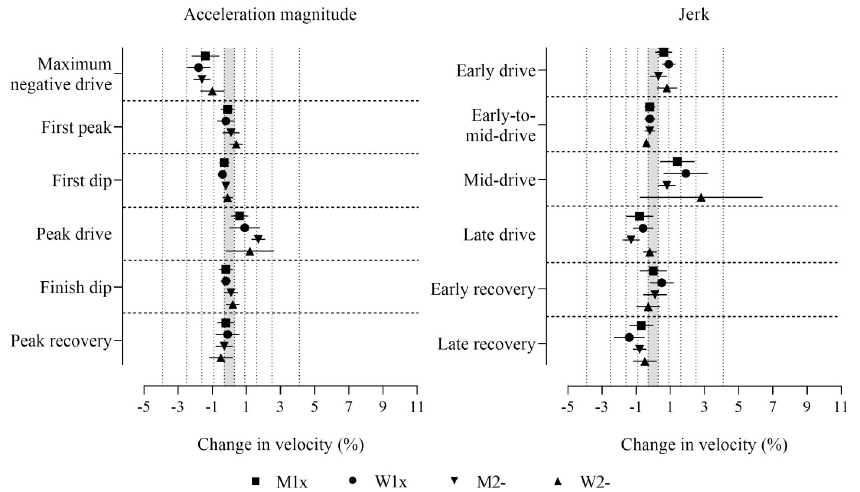
Fig 5. Change in boat velocity for a change in predictor variables of two within-crew standard deviations with adjustment for power output and stroke rate. Data are mean (%) and 90% compatibility intervals. The shaded grey area covers trivial values (values within the smallest substantial change thresholds, -0.3 to 0.3%). Vertical dotted lines delineate threshold magnitudes of small ( ± 0.3%), moderate ( ± 0.9%), large ( ± 1.6%), very large ( ± 2.5%), and extremely large (4.1, -3.9%). Effects with compatibility intervals that do not enter the grey area are decisively (very likely or most likely) substantial. Effects with compatibility intervals that end within the grey area have adequate precision (possibly or likely substantial or